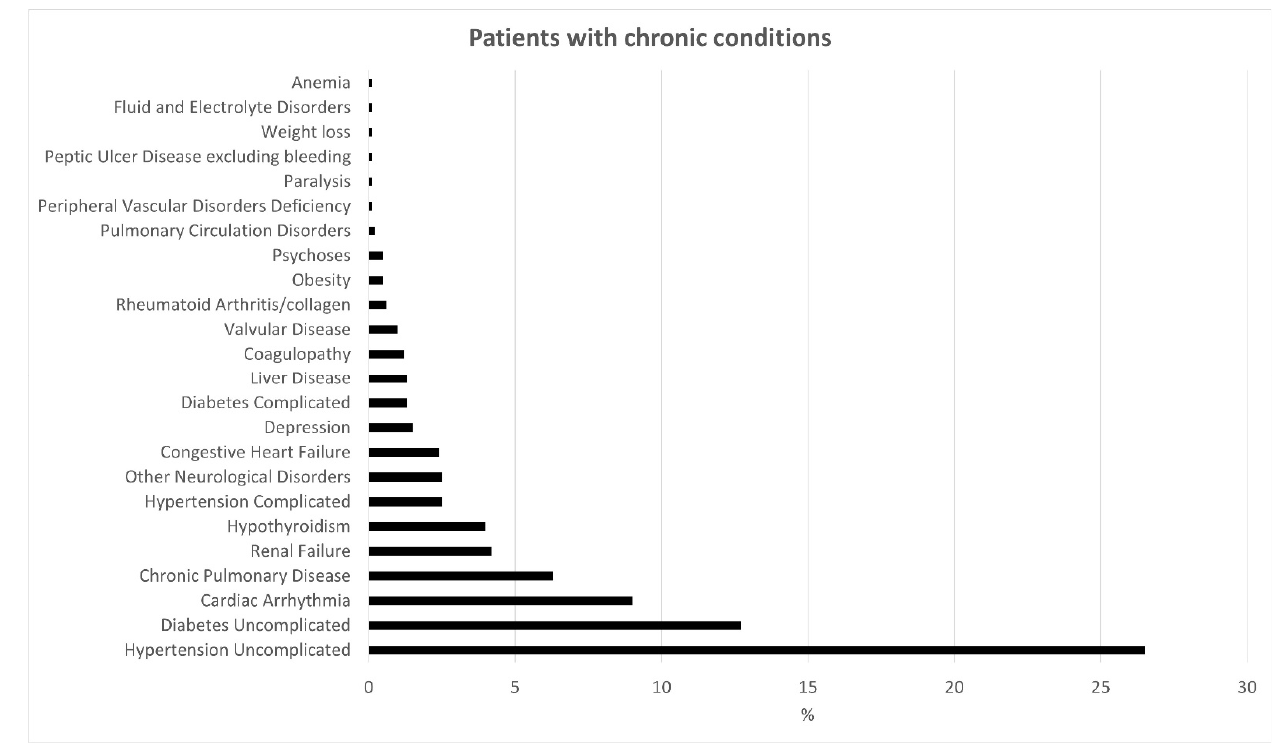
Figure 1. Percentage distribution (%) of the chronic conditions in the study population. In our cohort, 184 patients (20.1%) presented multimorbidity ( ≥ 2 comorbid condi- tions). Among the patients that showed chronic conditions, 280 (30.5%), 118 (12.9%), 48 (5.2%), 16 (1.7%) and 2 (0.22%) patients had 1, 2, 3, 4 and 6 comorbidities together, respec- tively (Table 2). Table 2. Multimorbidity and polytherapy in the study population.